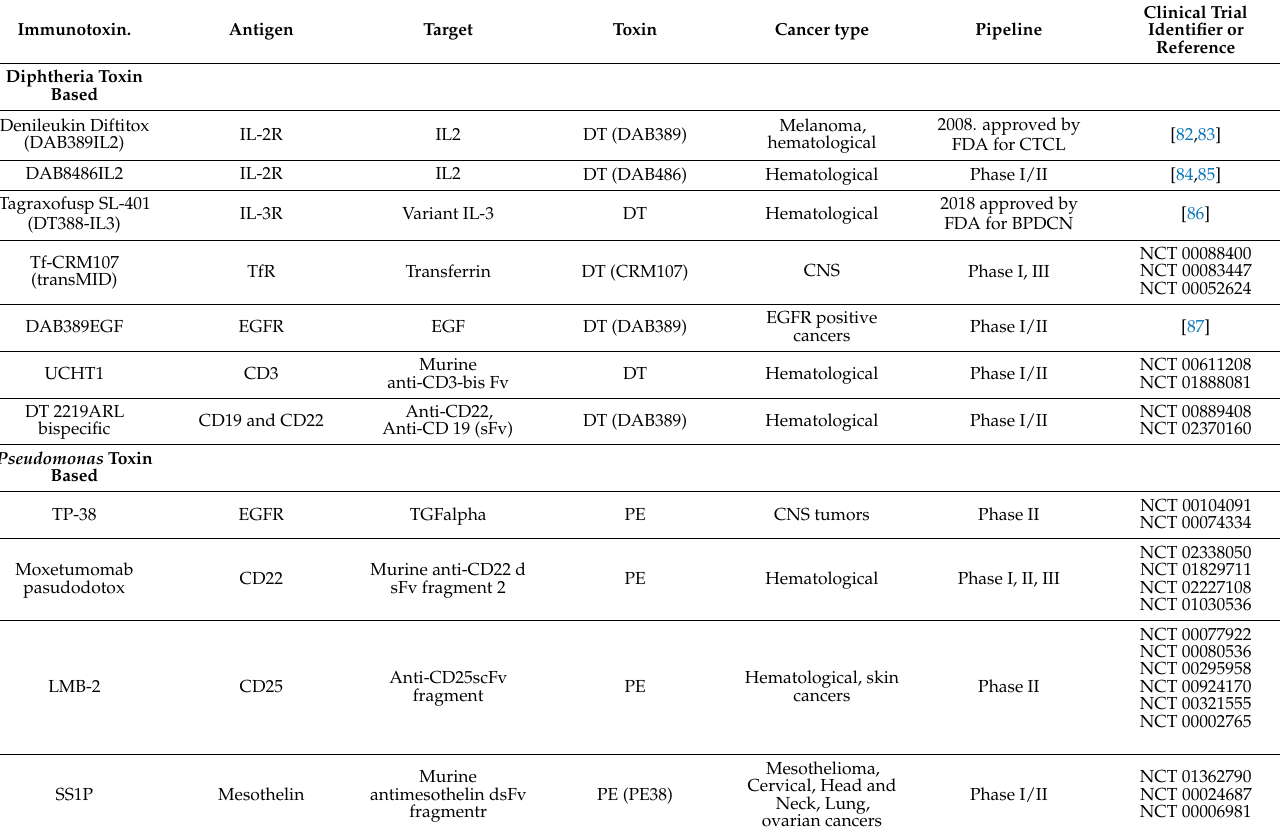
Table 3. Ligand-based and antibody-based immunotoxins approved or in phase II and III clinical trials [73].